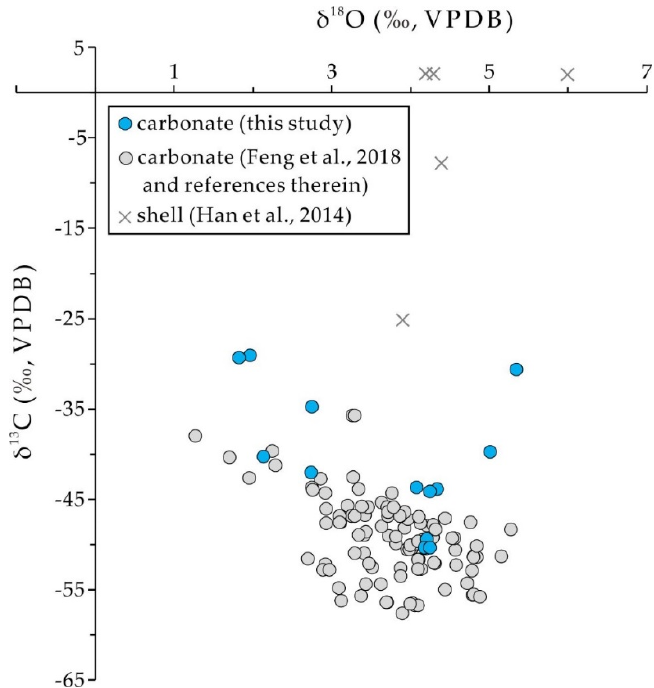
Figure 5. Cross plot of δ 13 C and δ 18 O values of carbonates and shells (published data for this site are from Feng et al. [30] and references therein).